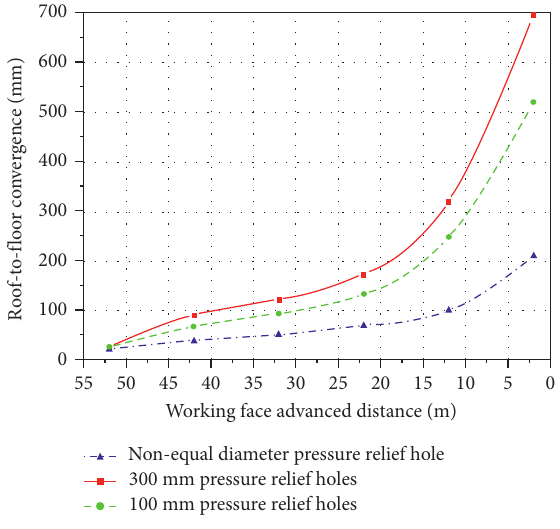
Figure 12: Roof-to-floor convergence curve.